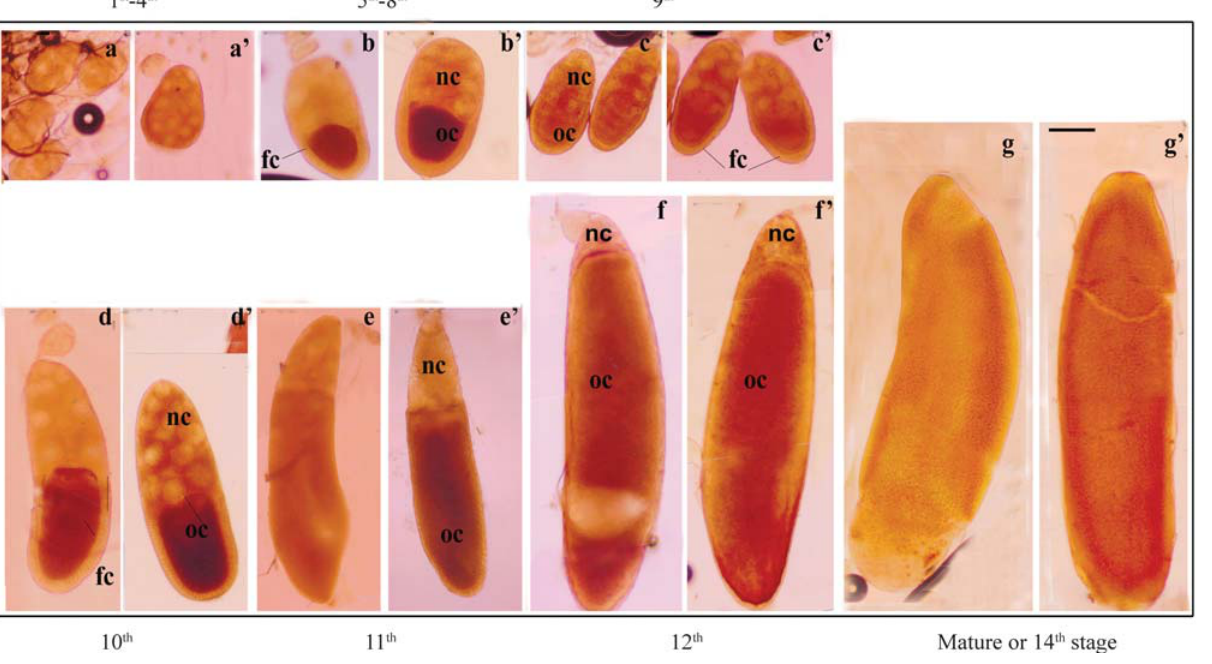
Figure 4B - Immunocytochemical staining of adult ovary to demonstrate in situ expression of HSP60 during the 1 st - 4 th (a, a’), 5th- 8th (b, b’), 9th (c, c’), 10th(d,d’),11th(e,e’),12th(f,f’)and14th(g,g’)stagesofoocytedevelopmentin M.domestica .Figuresa,b,c,d,efandgrepresentcontrols(C,25°C) and a’, b’, c’, d’, e’ f’ and g’ representing heat shocked (HS) oocytes. Bar represents 100 μ m in each figure. Oocyte = oc; nurse cells = nc; and follicle cells = fc.